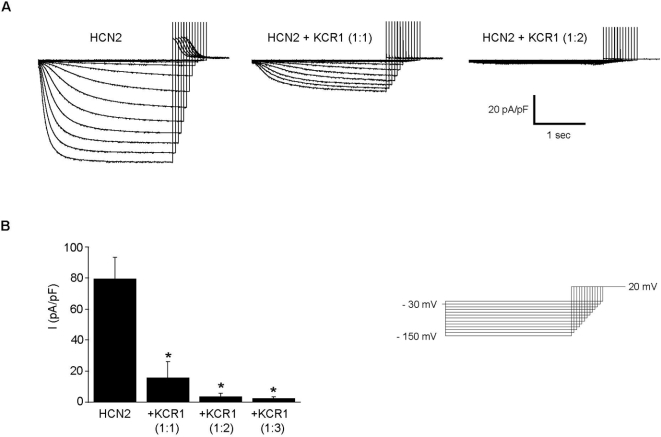
KCR1 suppresses recombinant IHCN2 current density.(A) Representative HCN2 whole-cell currents in absence and presence of KCR1. (B) Mean current densities of heterologously expressed HCN2 alone or together with KCR1 demonstrate that KCR1 significantly (*, p<0.001) reduced current density of recombinant IHCN2. For data see text.